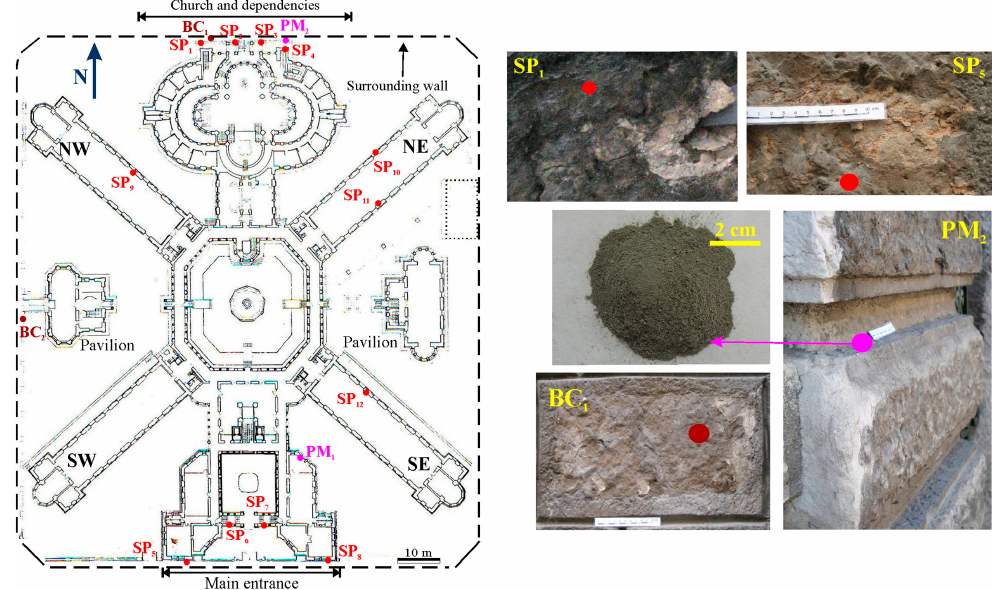
Figure 4. Plan view of the building showing sampling points to characterize the layers of black decay and in situ appearance of some of the surfaces sampled (BC: samples taken to study black crust; PM: settled dust sampled to determine the composition of the particulate matter; SP: samples taken to analyze air pollution-related spheres).